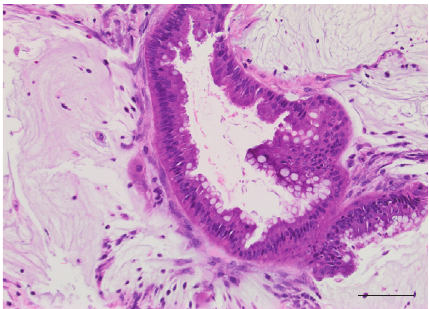
Figure 2: Diffuse reepithelialization of endometrium by low-grade appendiceal mucinous neoplasm with underlying weakly prolifera- tive endometrium with focal hemorrhage; 4x, H&E, and scale bar = 500